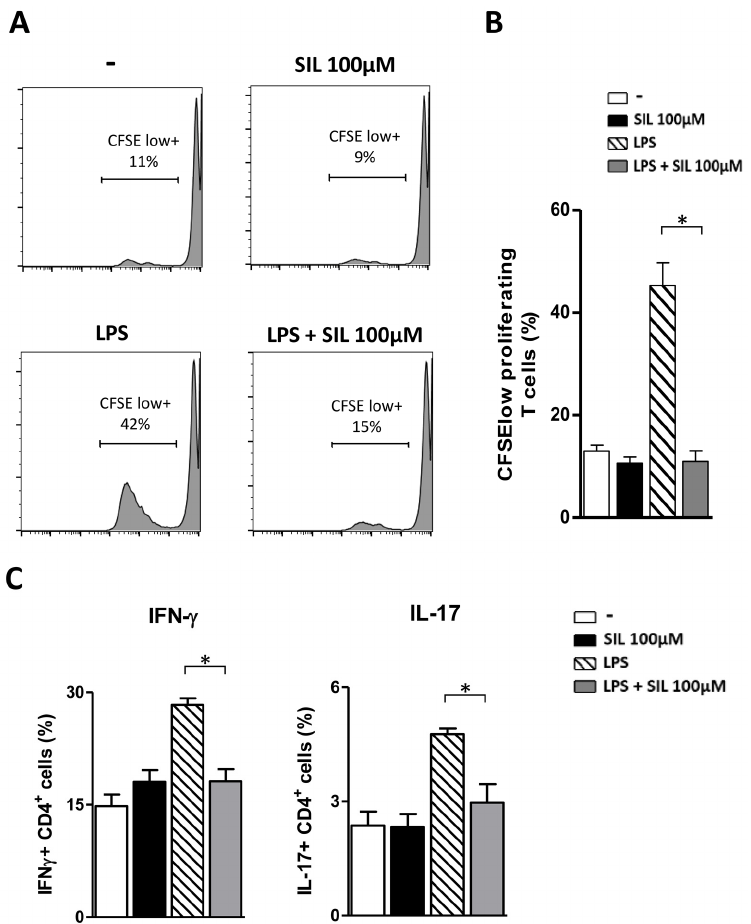
Figure 2. Silibinin impairs the allo-stimulatory ability of LPS-stimulated DC on memory CD4 + T lymphocytes. Human monocyte-derived DC were cultured for five days in IL-4 and GM-CSF-enriched medium and incubated for 24 h with medium alone, Silibinin (100 µM), LPS (100 ng/mL), or Silibinin with LPS. On day 6, a mixed leukocyte reaction (MLR) was performed. The DC were co-cultured with memory CD4 + T lymphocytes labeled with CFSE at a ratio of 1:10. ( A ) CD4 + T-cell proliferation was analyzed by flow cytometry after 7 days. The numbers in the histograms represent the percentage of dividing cells (CFSE low + ). The data are representative of three independent experiments performed. ( B ) Tests were conducted in triplicate and the results are expressed as the mean ± SD. ( C ) CD4 + cells were examined via intracellular cytokine staining. The percentage of intracellular IFN- γ + and IL-17 + CD4 + T-cells was determined by flow cytometry as described in Section 3. Results are expressed as the mean ± SD of three independent experiments performed. Statistical analysis was performed using GraphPad Prism Software v.5. * p < 0.05 was considered statistically